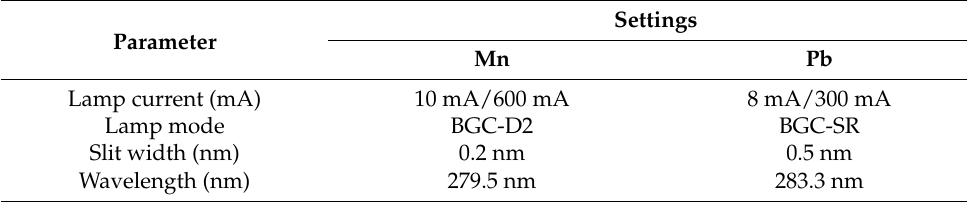
Table 1. Instrumental